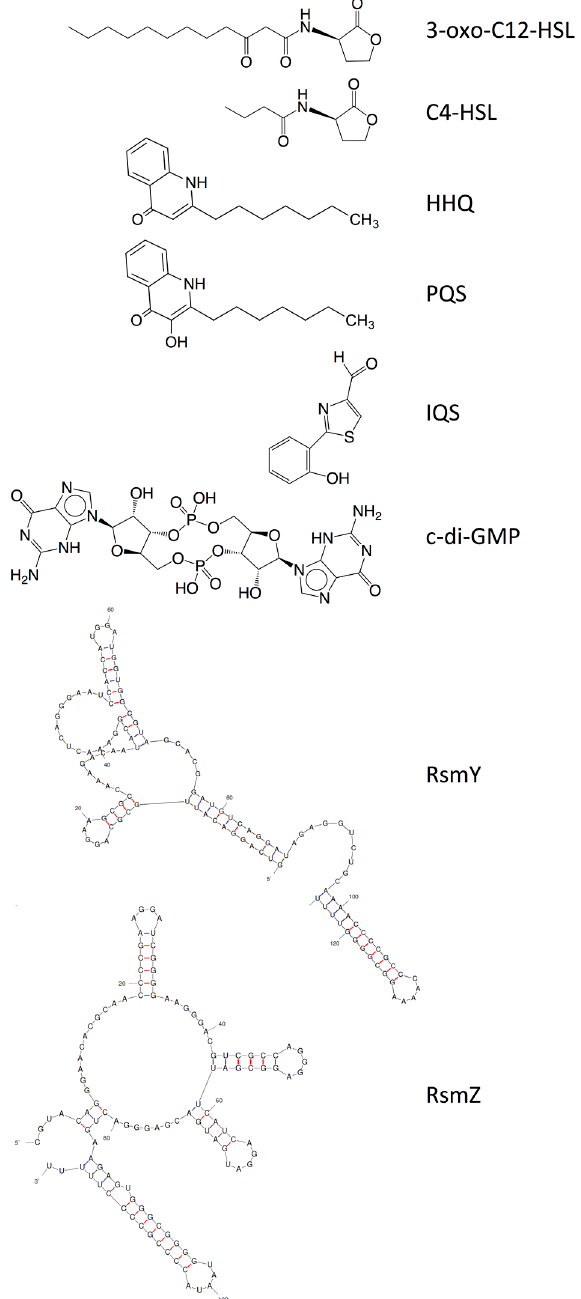
Figure 1. Structures of the native signal molecules of QS; 3-oxo-C12-HSL, C4-HSL, PQS, HHQ and IQS of P. aeruginosa as well as the internal signal molecule c-di-GMP of Gram-negative bacteria and predicted secondary structures generated using MFOLD (multiple fold) (http://mfold.rna.albany.edu/?q=mfold/RNA-Folding-Form) [15] of the non-coding regulatory small RNAs RsmY and RsmZ involved in the Gac/Rsm cascade from P. aeruginosa and P. flourescence . 3-oxo-C12-HSL: N -(3-oxododecanyol)- L -homoserine lactone, C4-HSL: N -butanoylhomoserine lactone, HHQ: 2-heptyl-4-hydroxyquinoline, PQS: 2-heptyl-3-hydroxy-4-guinolone, IQS: 2-(-hydroxyphenyl)- thiazole-4-carbaldehyde, c-di-GMP: bis-(3 ′ -5 ′ )-cyclic-dimeric guanosine monophosphate.